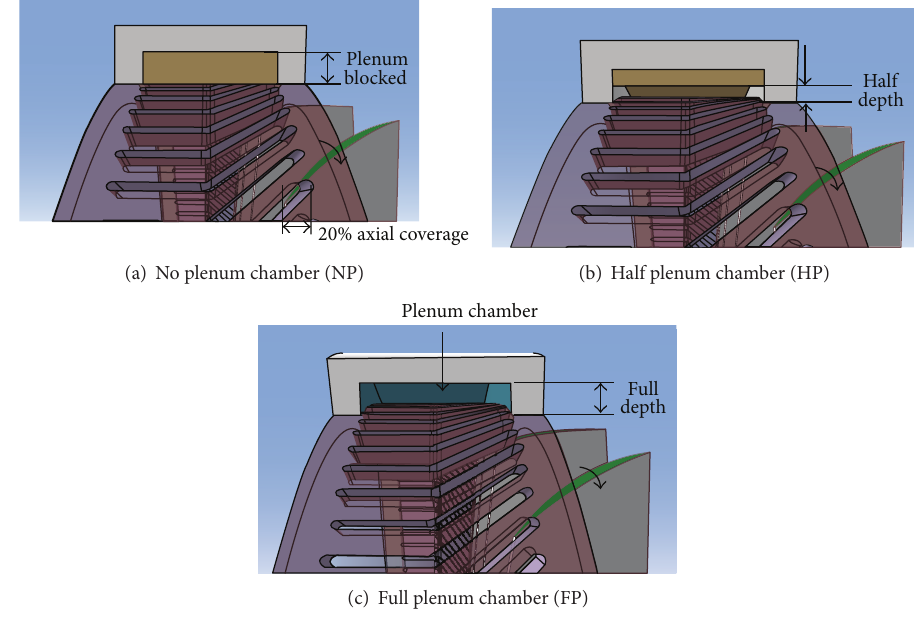
Figure 3: Casing treatments with three plenum chamber configurations at 20% coverage.